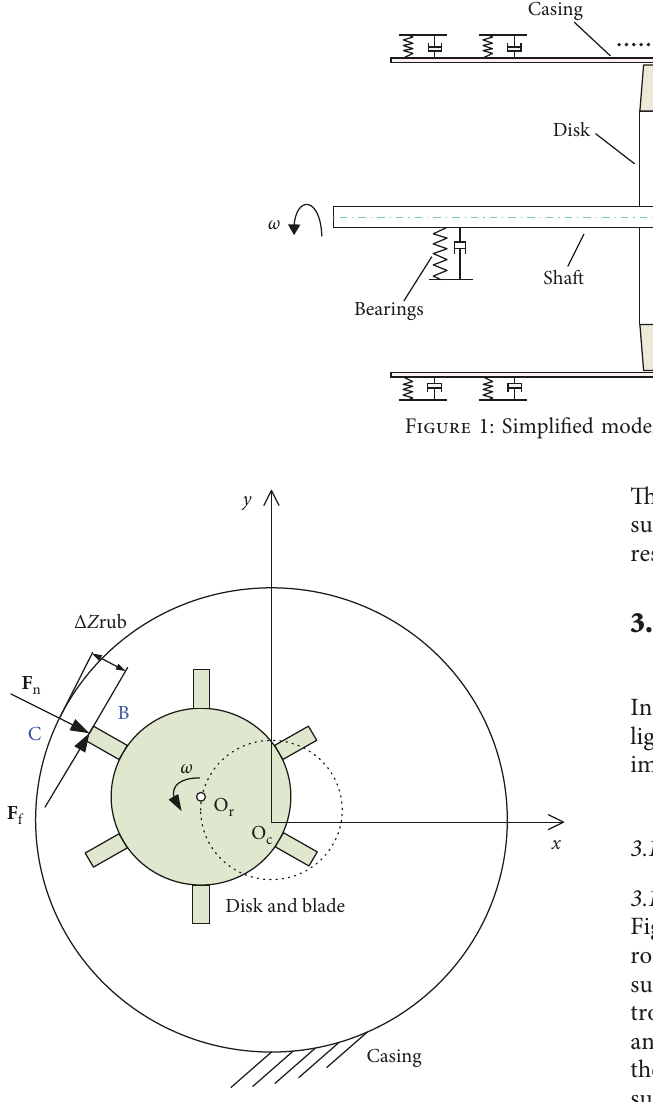
Figure 2: Model of a rotor rubbing against the casing.